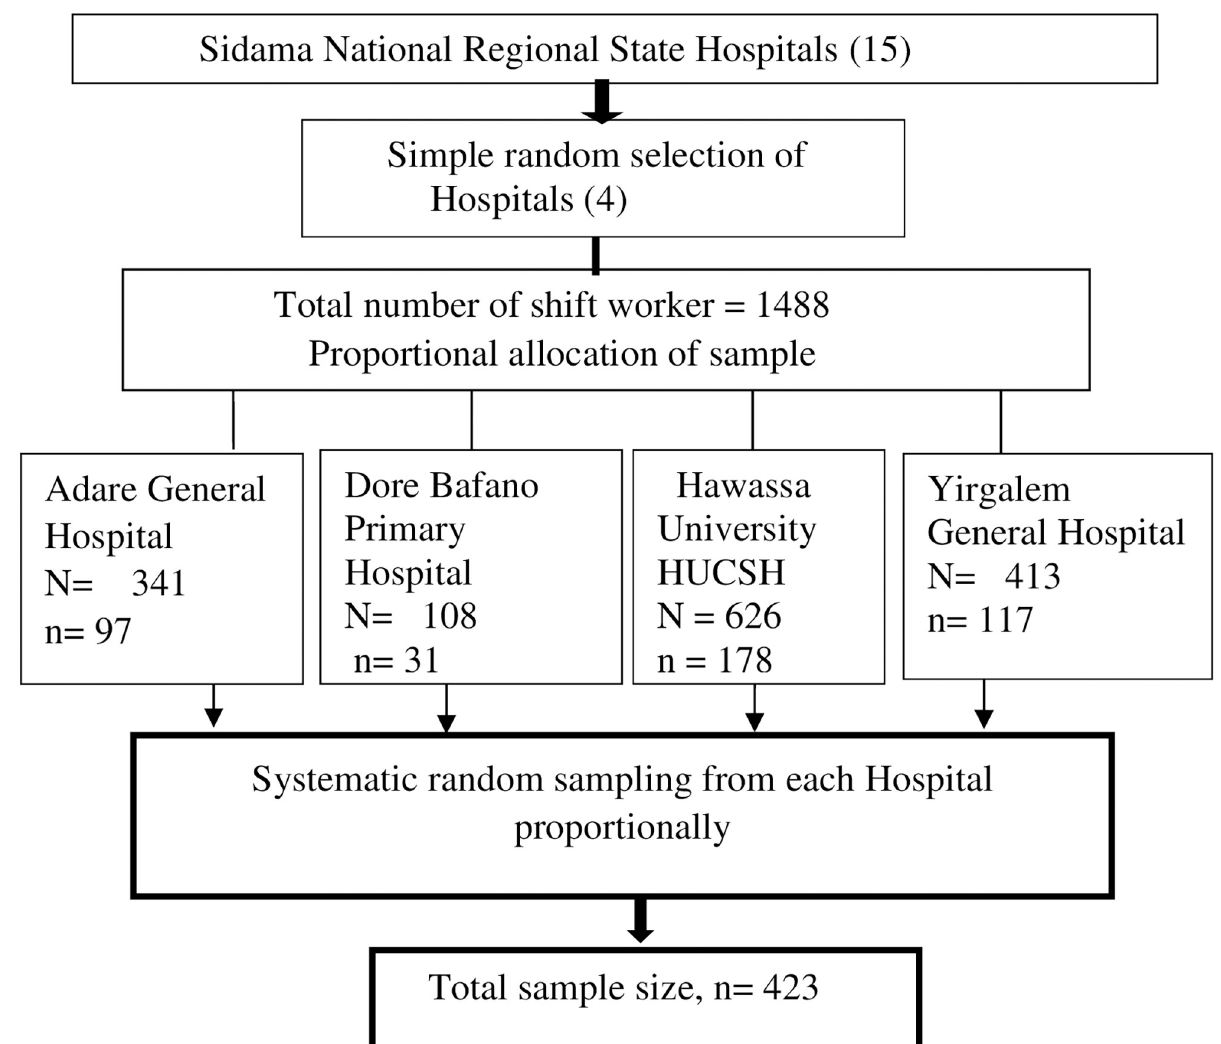
Fig 1. Sampling procedure for assessment of shift-work sleep disorder in health professionals, Sidama, Ethiopia, 2021.